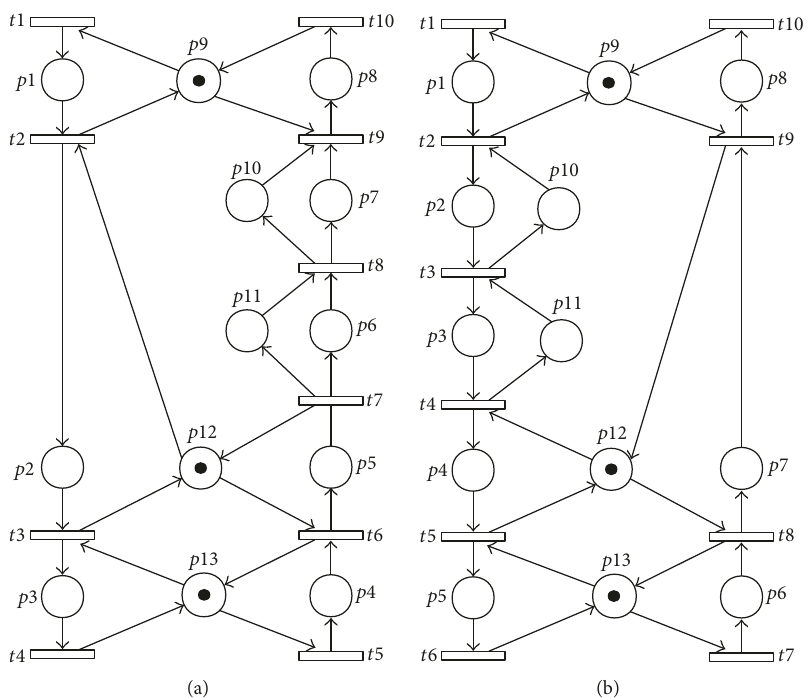
Figure 12: Two reduced S 3 PR models derived from Figure